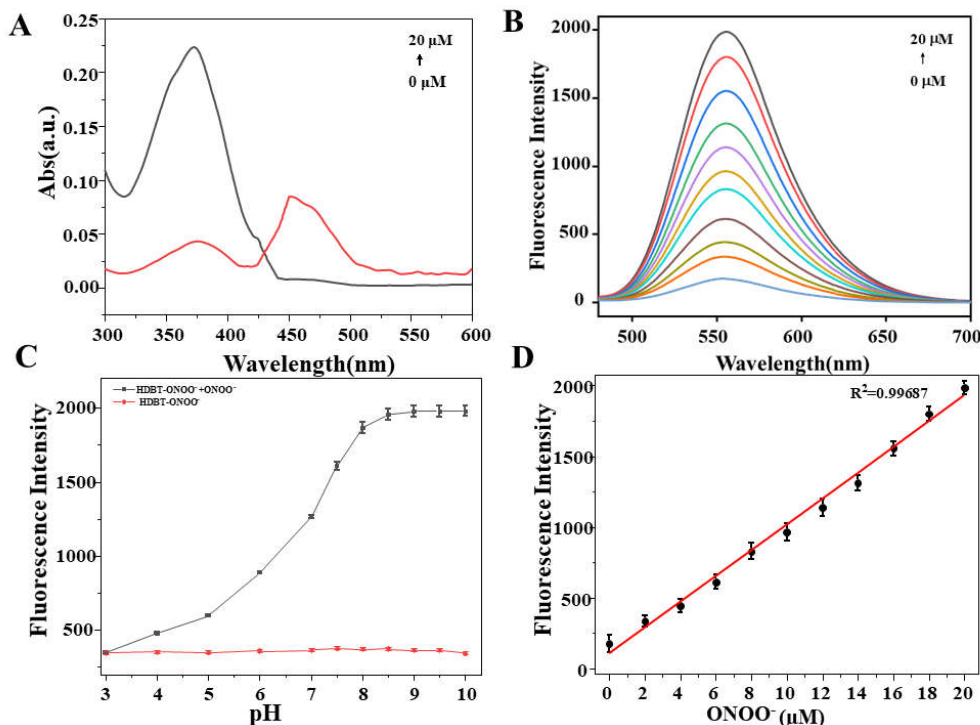
Figure 1. ( A ) UV–vis absorption spectra of HDBT-ONOO – (10 μM) after adding various concentra- tions of ONOO – (0–20 μM); ( B ) fluorescence response of HDBT-ONOO – (10 μM) to different con- centrations of ONOO – (0–20 μM); ( C ) fluorescence intensities of HDBT-ONOO – (10 μM) after adding ONOO - (20 μM) under different pH conditions; ( D ) linear relationship between HDBT-ONOO – (10 μM) and ONOO – concentration (0–20 μM). Experiments were repeated 3 times, and data are shown as the mean (± SD). The spectrum was obtained in PBS solution containing 5% DMSO (10 mM, pH 7.4, λ ex = 450 nm) at room temperature.